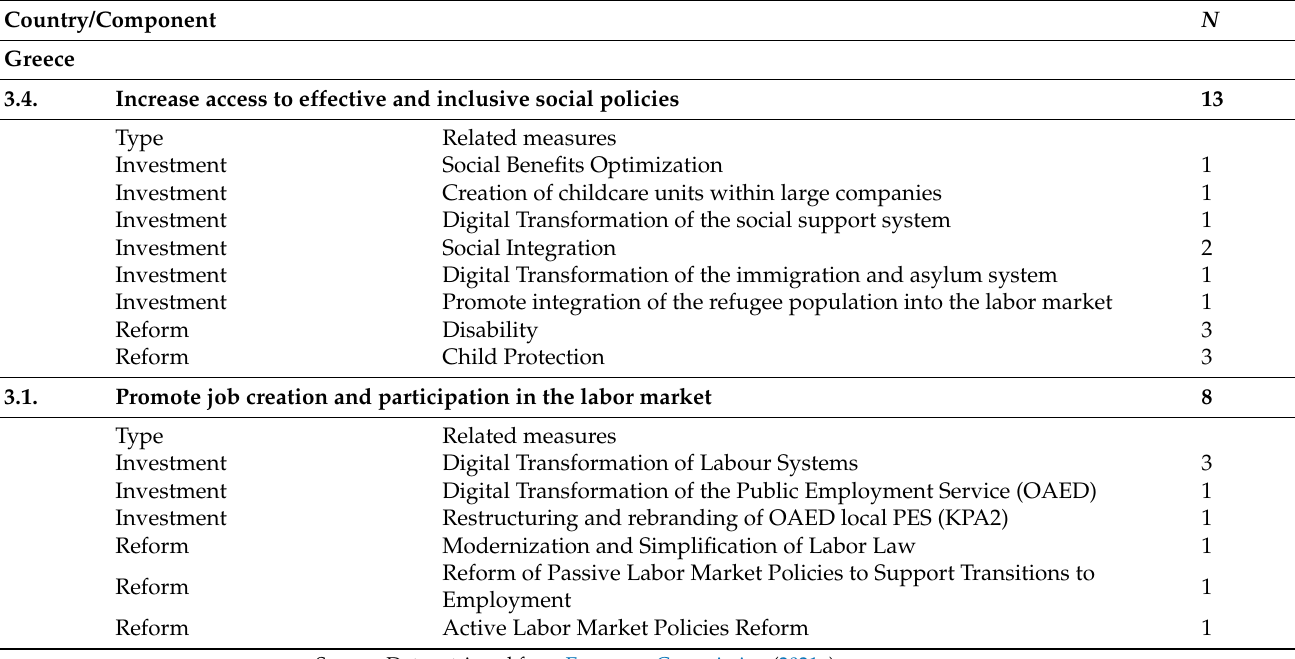
Table 4. Social and employment protection measures in the Greek recovery and resilience plan.